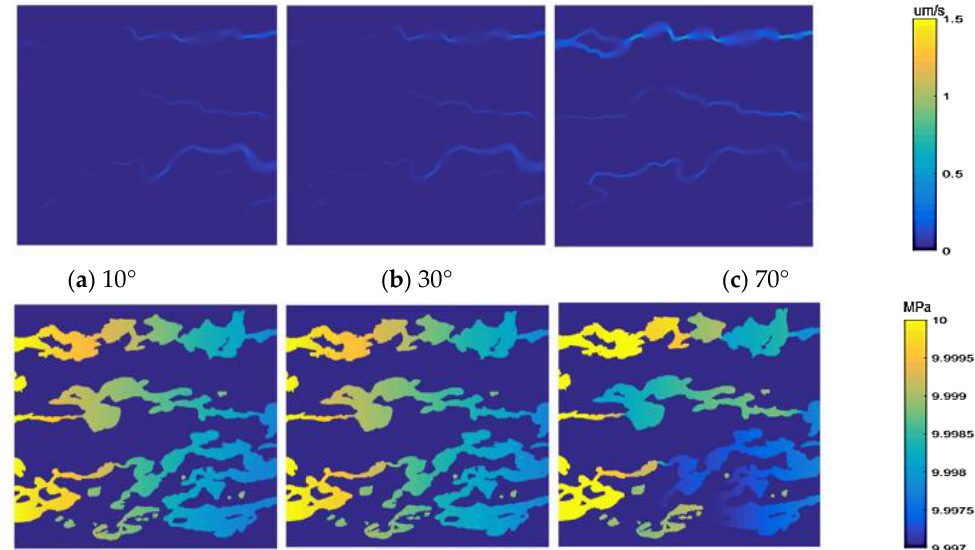
Figure 18. Simulation results under different wetting angles of the oil phase.